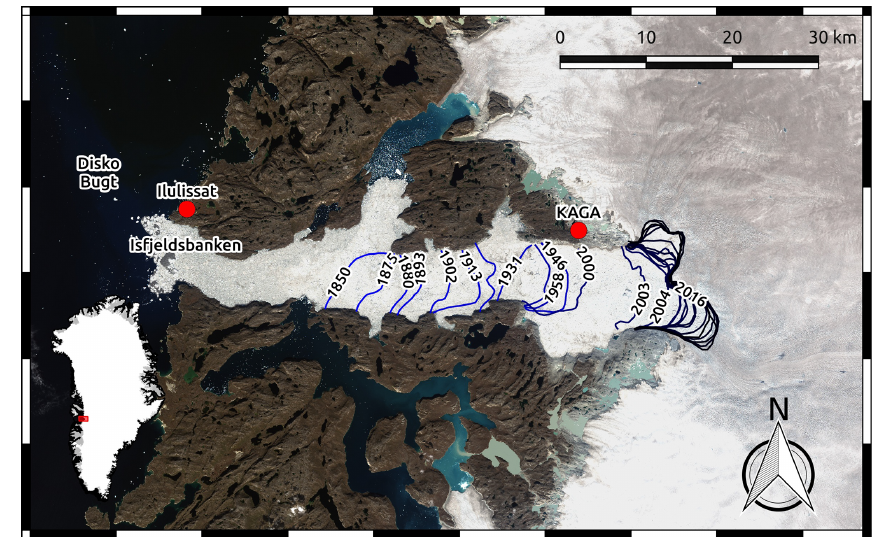
Figure 1. Glacier front positions of Jakobshavn Isbræ from Khan et al. (2015) (1850–1985) and CCI products derived from ERS, Sentinel- 1 and Landsat data by ENVO (1990–2016). The background map is a Landsat-8 image from 16 August 2016 (from the U.S. Geological Survey). Location names that occur in the text are marked. The inset shows the location of Jakobshavn Isbræ in